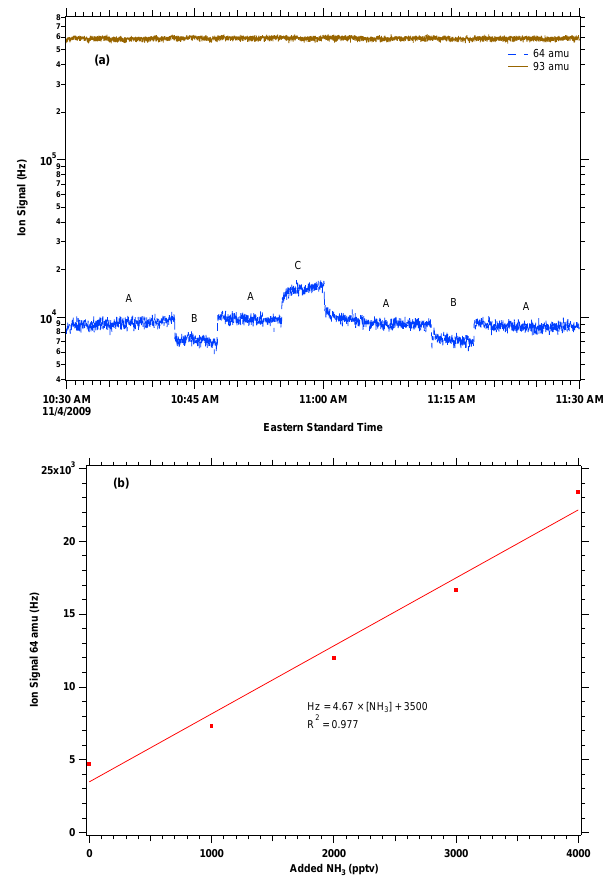
Fig. 4. (a) A typical ambient measurement sequence including the ambient (A), background (B), and calibration mode (C) measure- ments. Raw ion signals taken with a 1s time resolution are shown here. (b) A calibration curve for the CIMS instrument. The air go- ing into the CIMS was from flow tube air (a mixture of nitrogen gas and water vapor with RH 12%) and entered the CIMS at 5slpm. The solid line indicates the linear fitting of the measurement data and the slope is the same as the